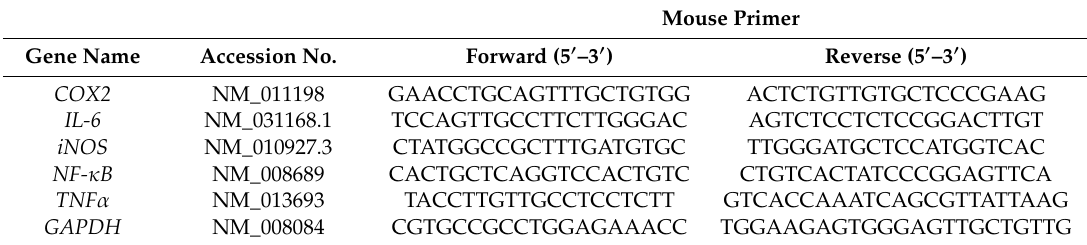
Table 1. Sequences of the primers used in the current